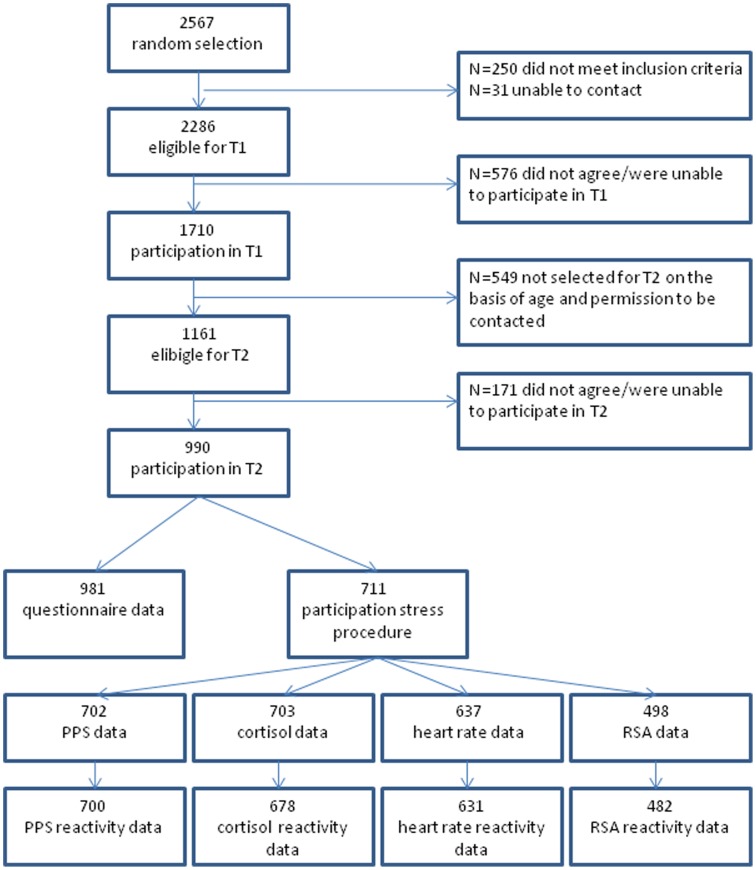
Flow-chart of available data.
Notes. PPS = perceived physiological stress; RSA = respiratory sinus arrhythmia.